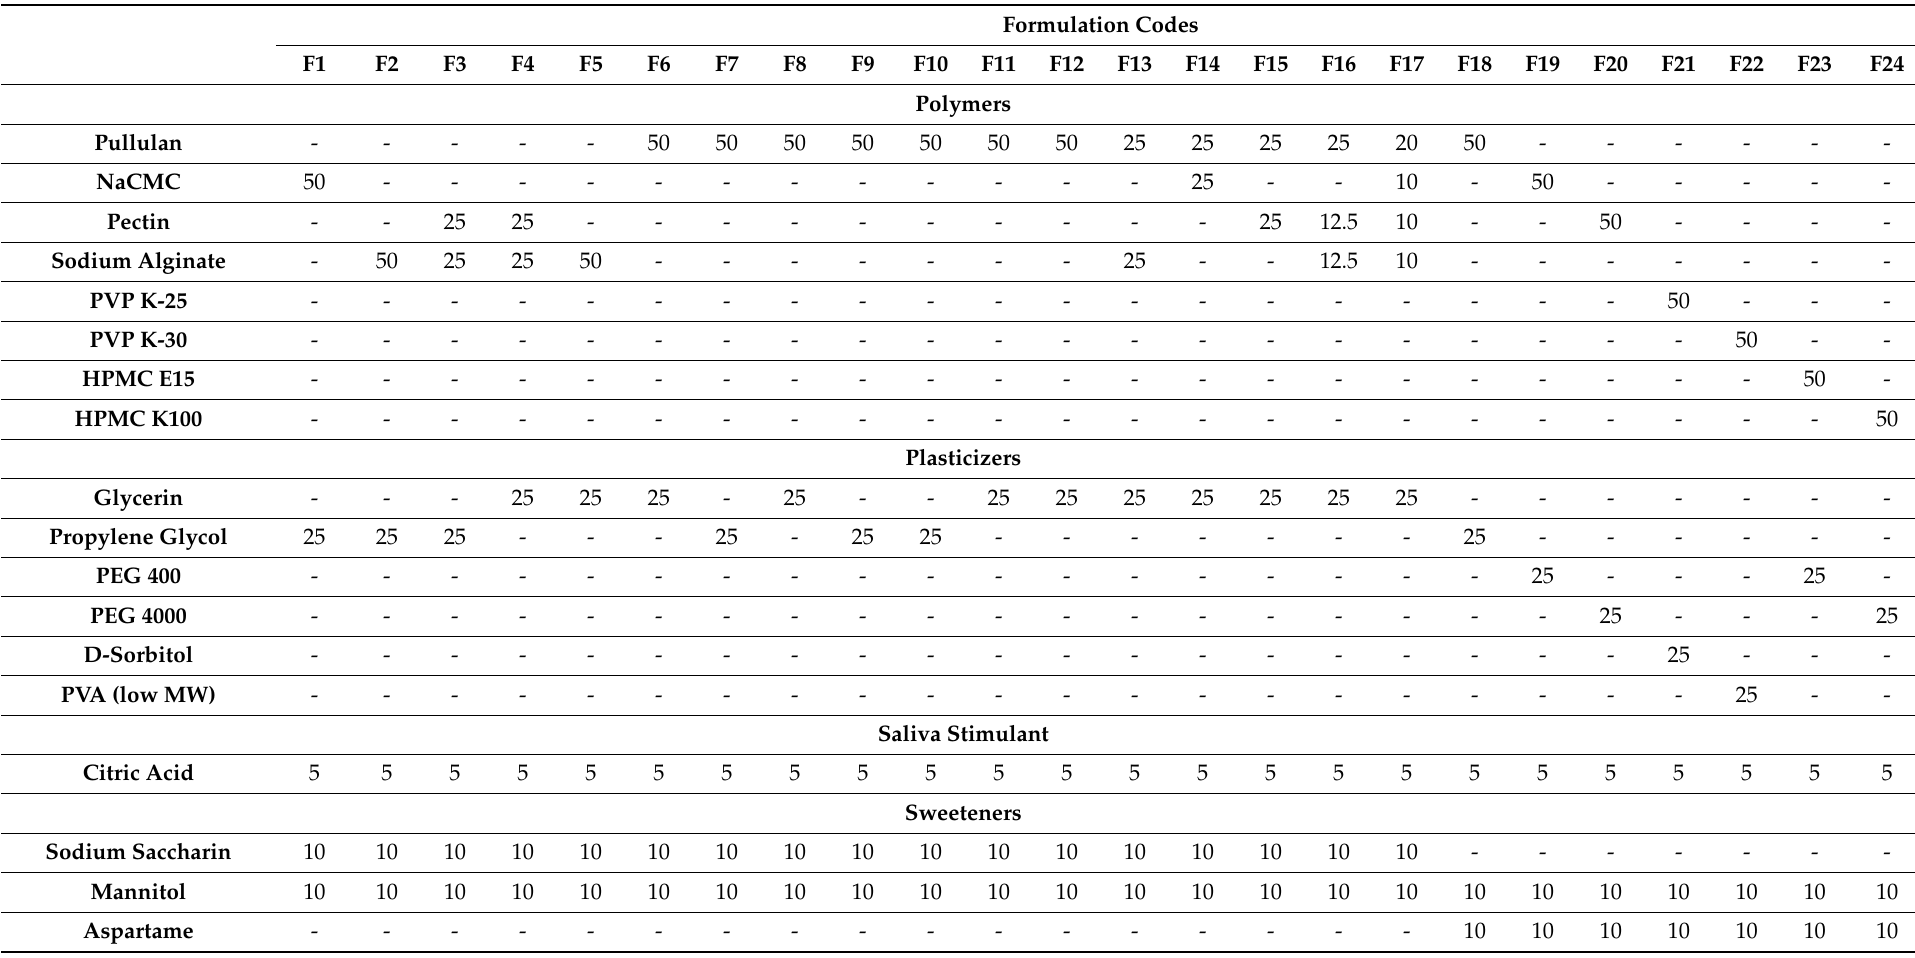
Table 10. OTF formulations and components (mg) containing